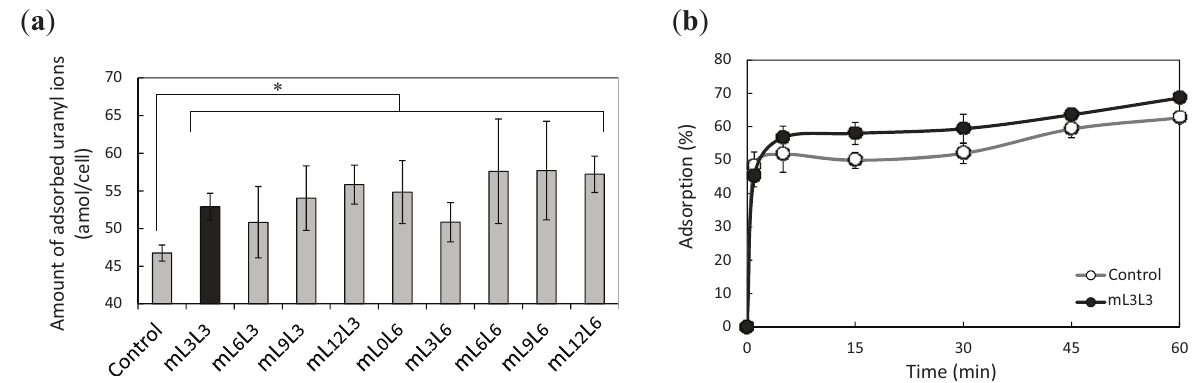
Figure 3. Cell-surface adsorption of uranyl ions by surface-engineered yeasts. ( a ) Uranyl ion adsorption on a single cell at pH 4.0 was quantified by dividing the number of adsorbed uranyl ions by the number of yeast cells; ( b ) Time-dependent changes in adsorption efficiency of uranyl ions at pH 4.0. Data represent the means ± S.E.M. of three independent experiments. * p < 0.05, determined by Dunnett’s